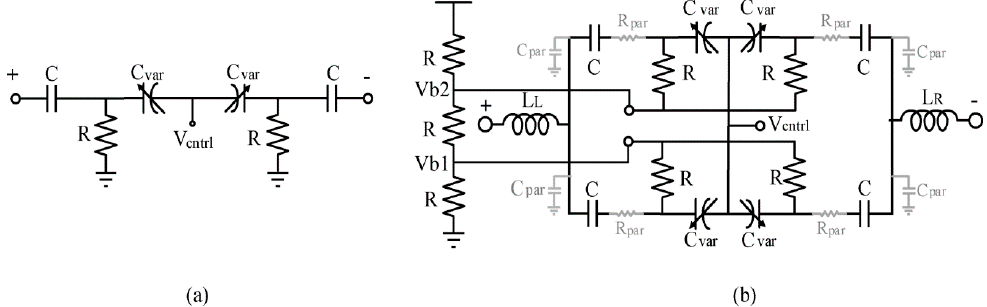
Figure 3. Schematics of the ( a ) conventional and ( b ) proposed wideband varactor with parasitics highlighted.